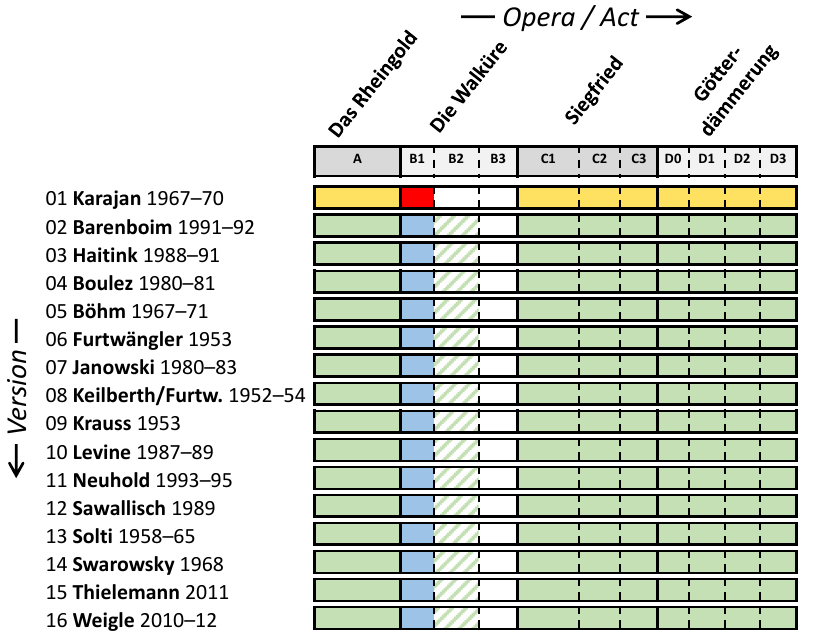
Figure 2. Cross-version dataset comprising 16 versions of Wagner’s Der Ring des Nibelungen WWV 86. As test data, we use the first act of the second opera Die Walküre (WWV 86 B1) in the version conducted by Karajan (red). Training data stems either from the same version but other operas ( opera split , yellow), from the same act in other versions ( version split , blue), or from other operas in other versions ( neither split , green). The hatched green cells (B2) indicate a variant of the neither split , where the training data stems from another act of the same